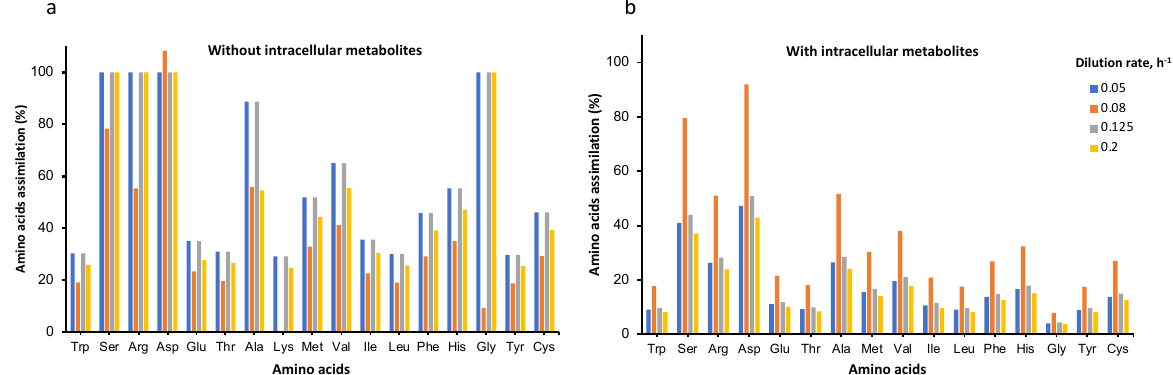
Figure 2. Simulated amino acid assimilation. The assimilation percentage of each amino acid at different dilution rates was evaluated a) with restrictions due to exchange reactions and b) with restrictions due to both exchange reactions and intracellular metabolite reaction determined with feasible solution. Trp: tryptophan, Ser: serine, Arg: arginine, Asp: aspartate, Glu: glutamate, Thr: Threonine, Ala: alanine, Lys: lysine, Met: methionine, Val: valine, ile: isoleucine, Leu: leucine, Phe: phenylalanine, His: histidine, Gly: glycine, Tyr: tyrosine, Cys: